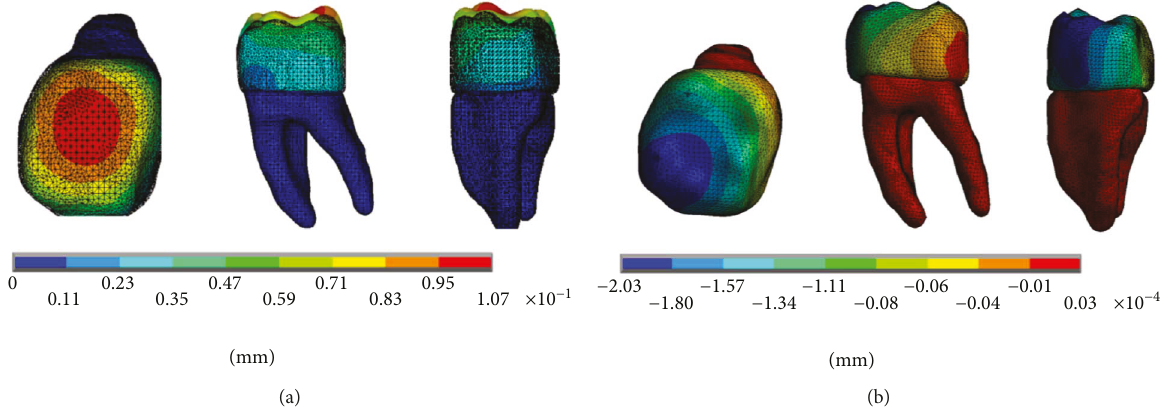
Figure 18: Displacements in the z -axis. (a) Noncontact. (b) Contact.